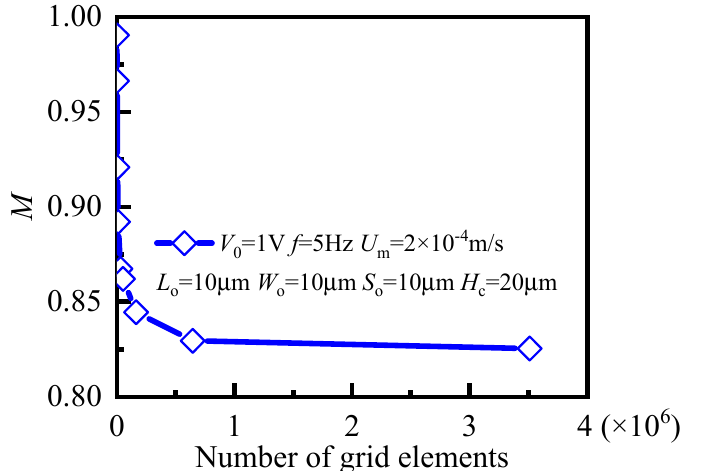
Figure 2. Grid-dependency test for mixing-efficiency index M at B-B cross-section.